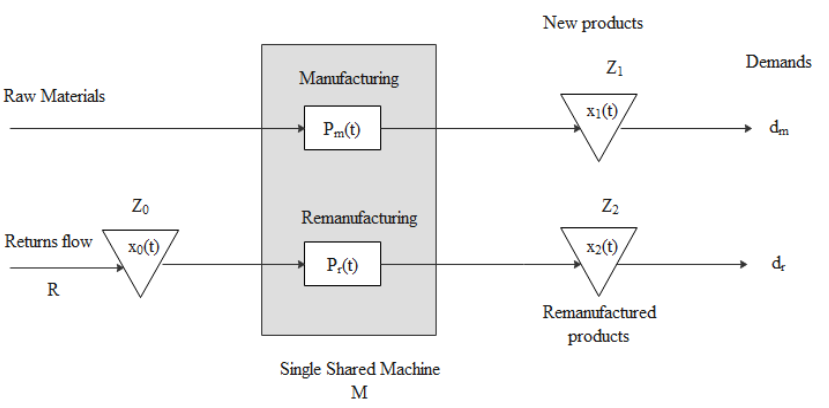
Fig. 1. Production system with recovery